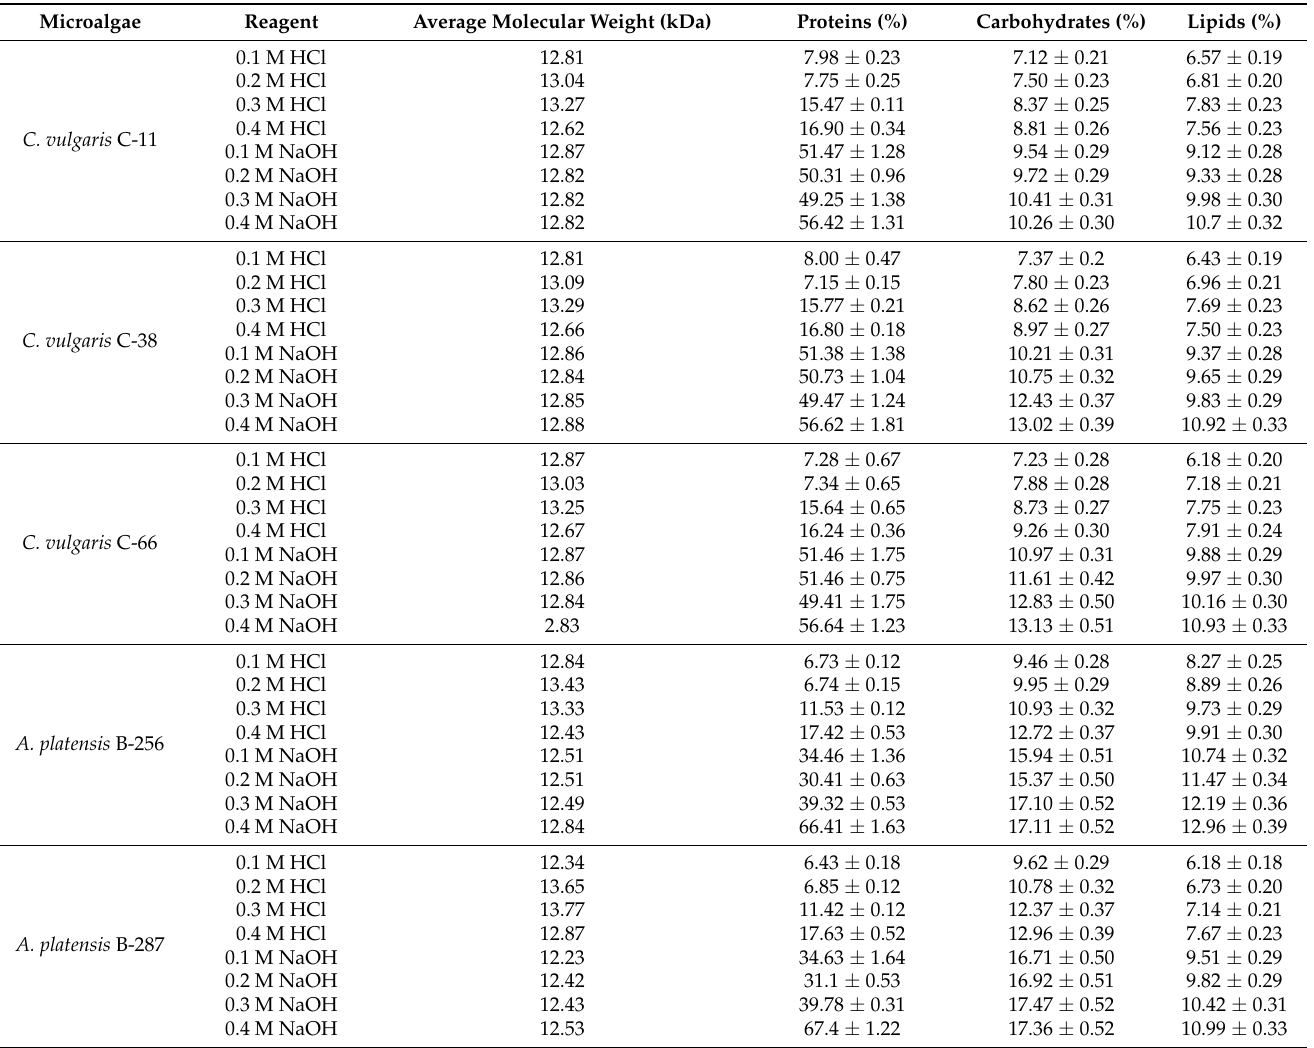
Table 3. Characterization of chemically extracted proteins, carbohydrates,